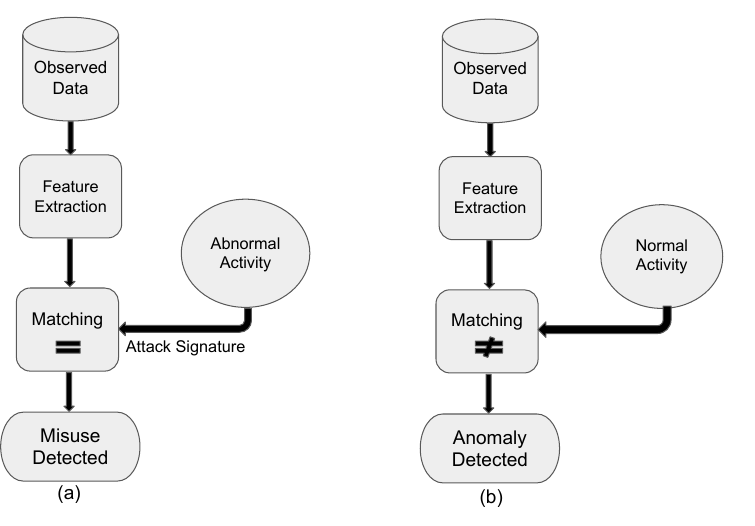
Figure 7. Figure illustrates ( a ) signature-based threat detection, ( b ) behavior-based (or anomaly) detection. The idea is adopted from